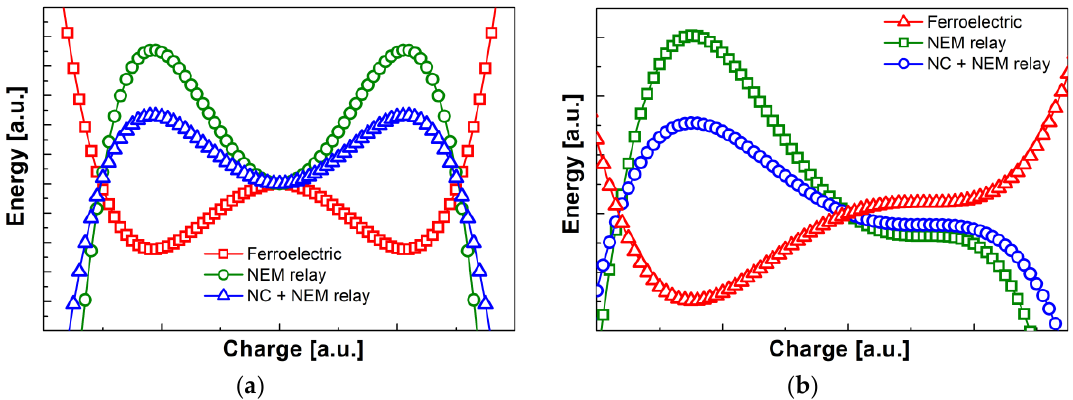
Figure 3. ( a ) Simulated energy landscapes of ferroelectric capacitor, NEM relay and NC + NEM relay in equilibrium state; ( b ) simulated energy landscapes of ferroelectric capacitor, NEM relay and NC + NEM relay when pull-in voltage is applied.